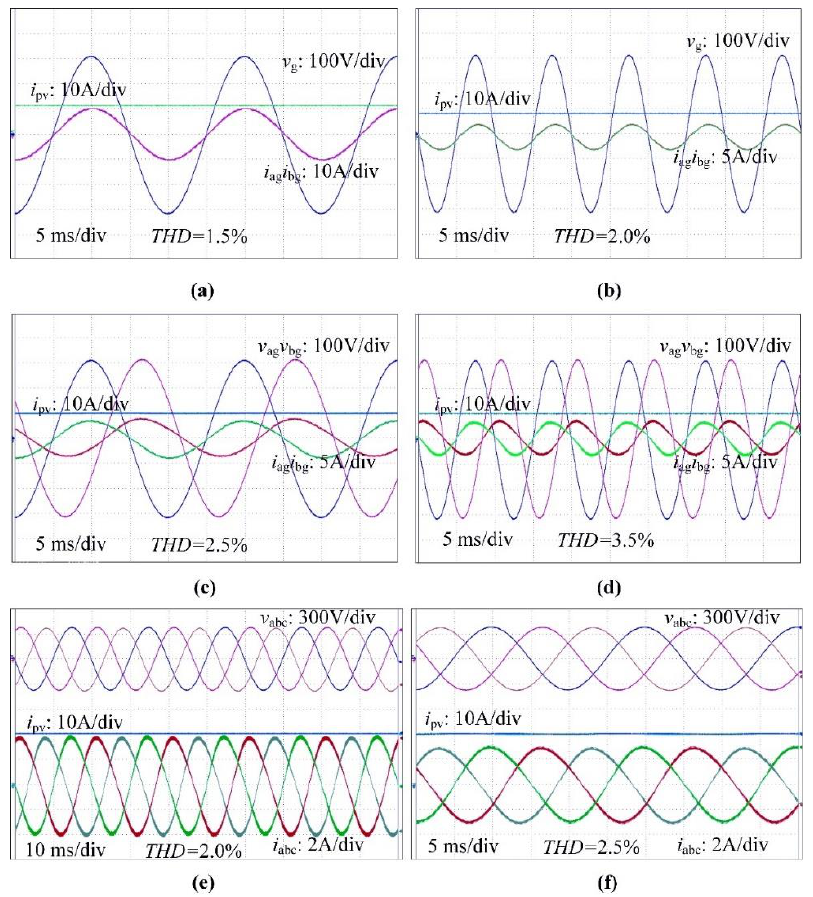
Figure 13. Grid-connected comparison of combined 3CH4 current sources: ( a ) Independent CH4 in parallel to a single-phase grid; ( b ) Common DC bus type CH4 in parallel to a single-phase grid; ( c ) Independent CH4 in parallel to a two-phase grid; ( d ) Common DC bus type CH4 in parallel to the two-phase grid; ( e ) Independent CH4 in parallel to the three-phase grid; ( f ) Common DC bus type CH4 in parallel to the three-phase grid.